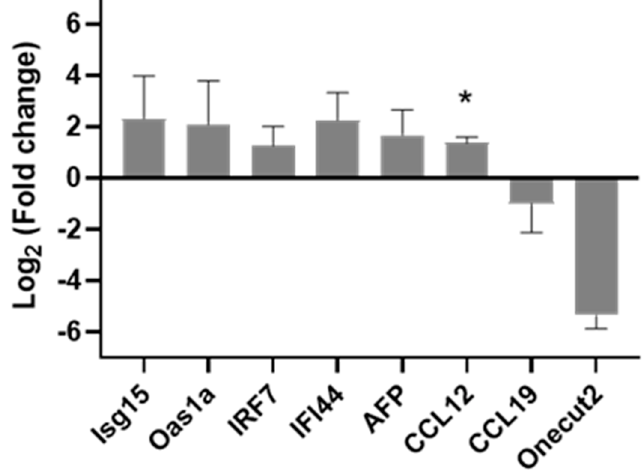
Figure 6. Fold change in selected target genes in the 2 ′ -FL group with respect to REF by Taqman PCR ( n = 4–8/group). Statistical differences: * p < 0.05 vs. REF.